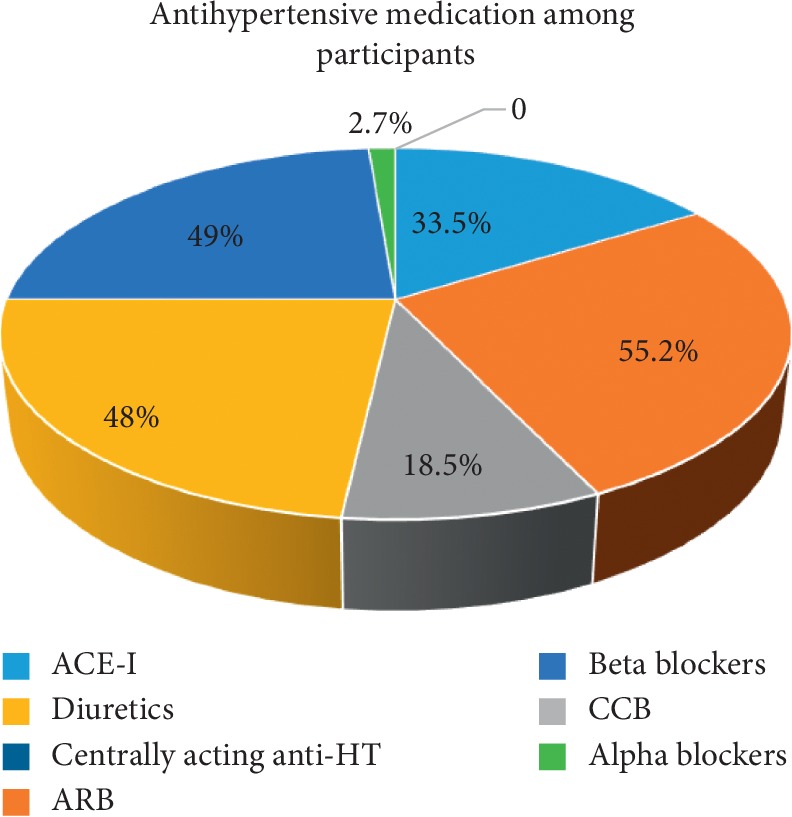
Antihypertensive medications among participants.